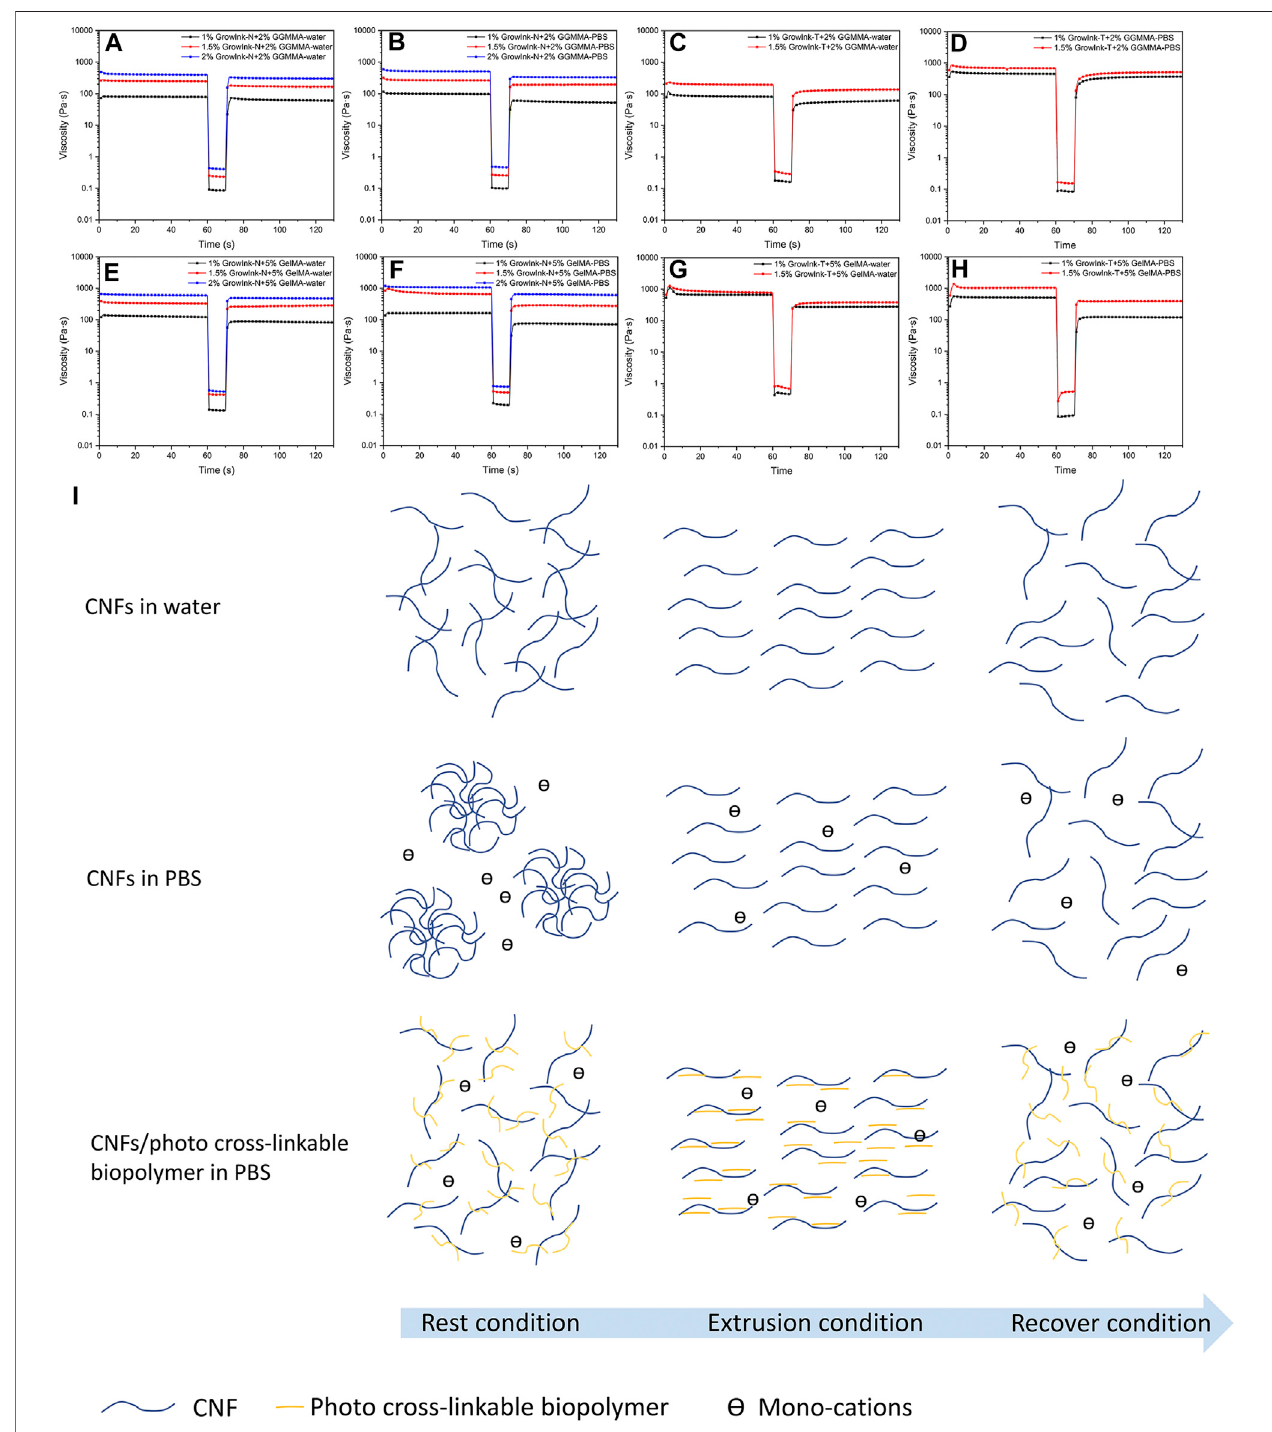
FIGURE 4 | Thixotropic behavior of the inks (A – D) GrowInk-N-GGMMA – and GrowInk-T-GGMMA – based inks, (E – H) GelMA incorporated GrowInk-N – and GrowInk-T – basedinks diluted withPBSbuffer andwater,respectively, and (I) schematicillustrationofthemicrostructureoftheinksduring theextrusion process. CNFs showedastable microstructural networkinwater. Thenano fi brilswereorderlyarrangedduring theextrusion conditionand slowlyrecovered toanetworkstructure after extrusion, whereas the CNFs in PBS buffer were aggregated into fl ocs at the rest condition and broke into individual nano fi brils during the extrusion process. The nano fi brils were not able to form into fl ocs immediately after extrusion. In contrast, the photo-crosslinkable polymer of GGMMA or GelMA absorbed on the surface of CNFs could signi fi cantly prevent fl oc formation, thus increasing the microstructure network stability during the extrusion process.